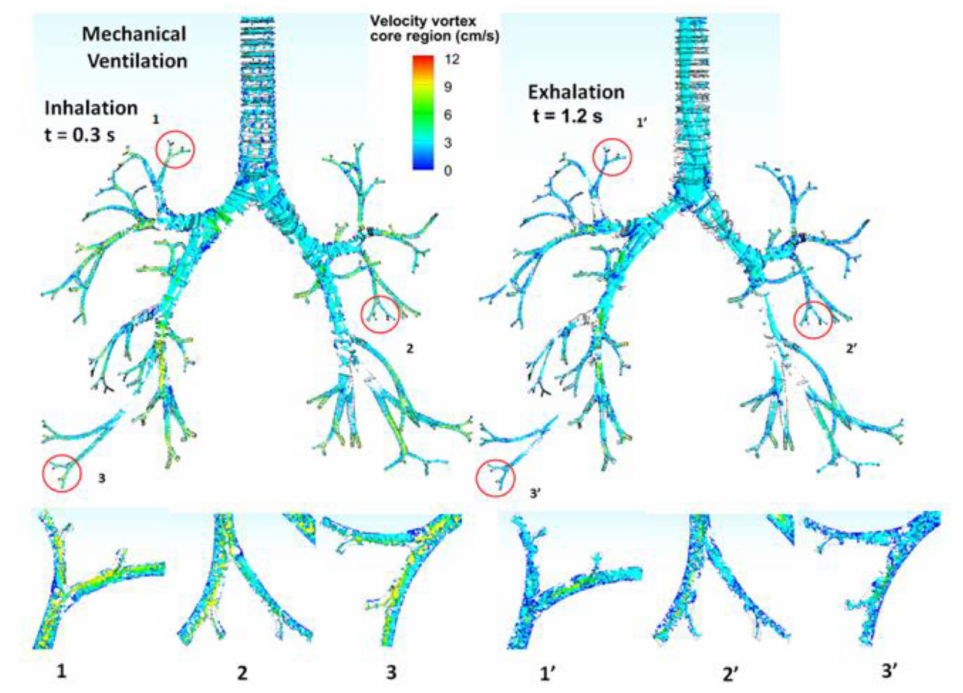
Figure 6. Turbulent spot prediction for Mechanical Ventilation: Vortices through iso-surface during inhalation (t = 0.3 s) and exhalation ( t = 1.2 s) for mechanical ventilation with highlighted local bifurcations. Selected local bifurcations are two from right lung and one from left lung.